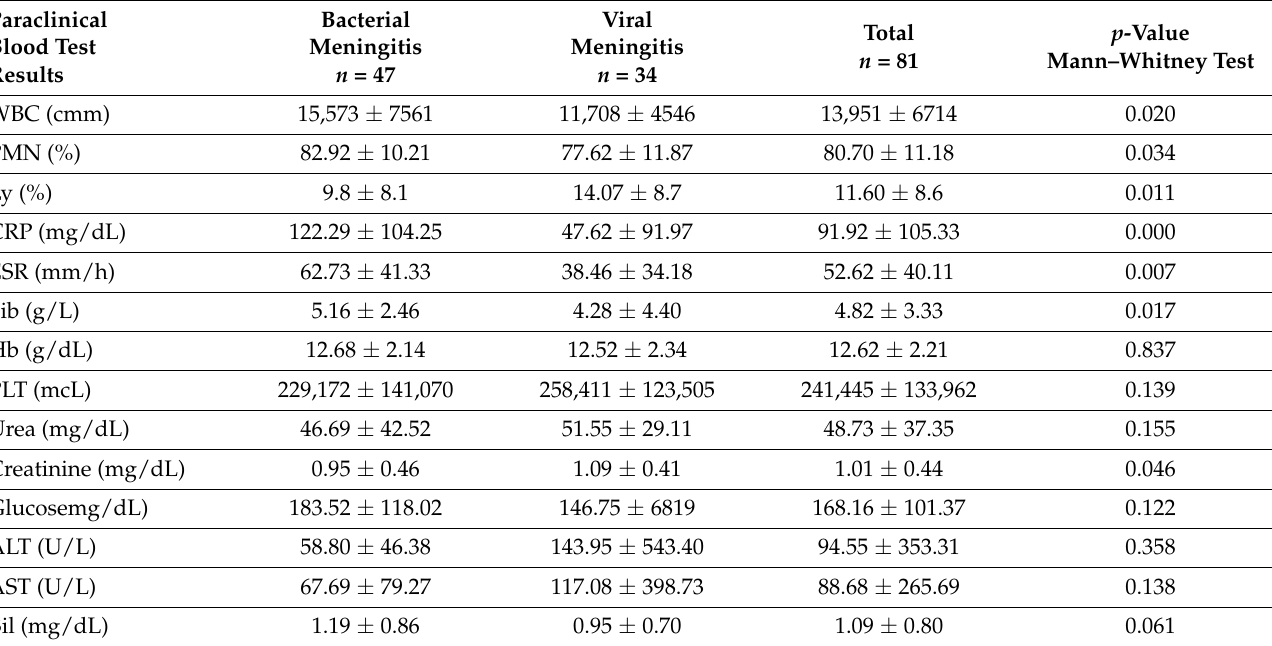
Table 4. Paraclinical blood test results.